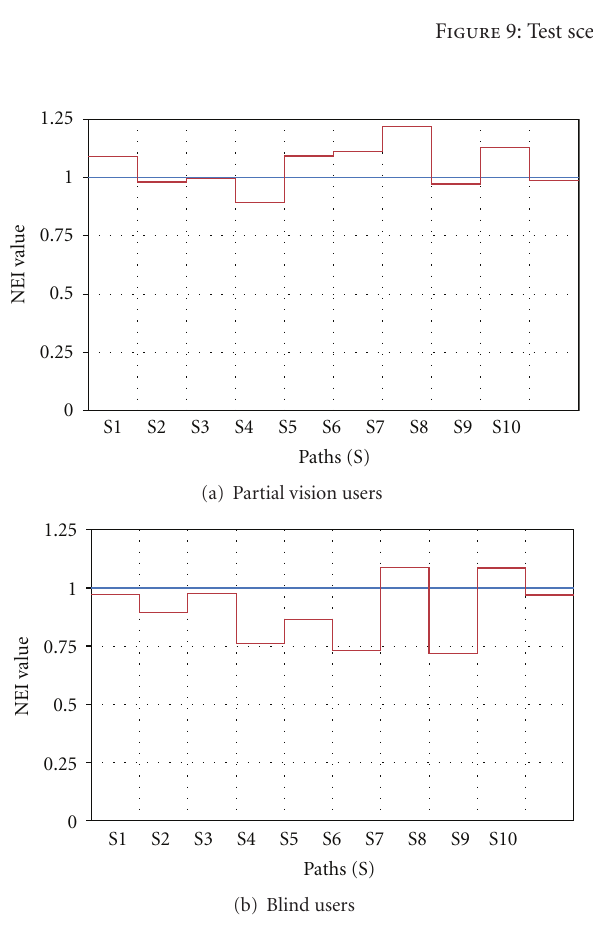
Figure 10: Navigation E ffi ciency Index, NEI, versus subpaths (S).